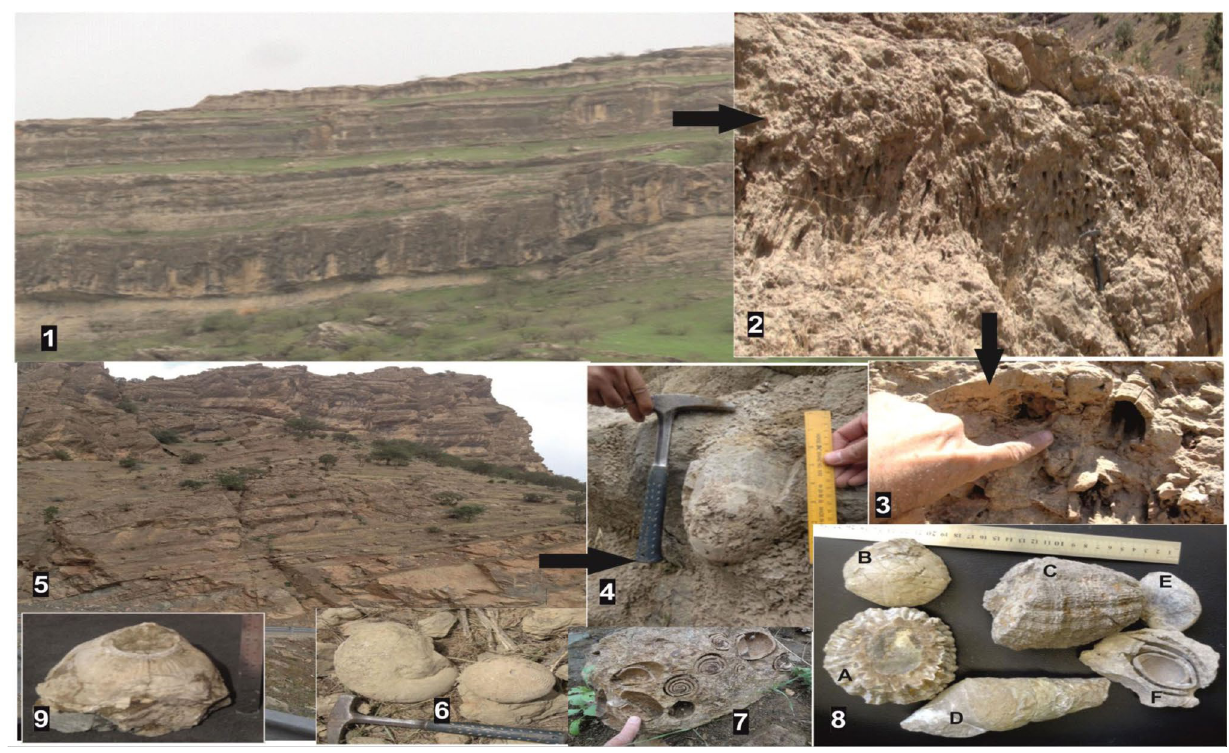
Fig. 6 Massive middle ramp carbonates. 2. Rudist reef body. 3. Pre- radiolites predominated in the middle ramp facies associations from Aqra fn. 4. Giant rudist solitary Hippurites (Duriana) from Sura Qalat section, imbricated zone. 5. Massive Aqra carbonate middle platform, Choman section. 6. Ammonites and echinoids association